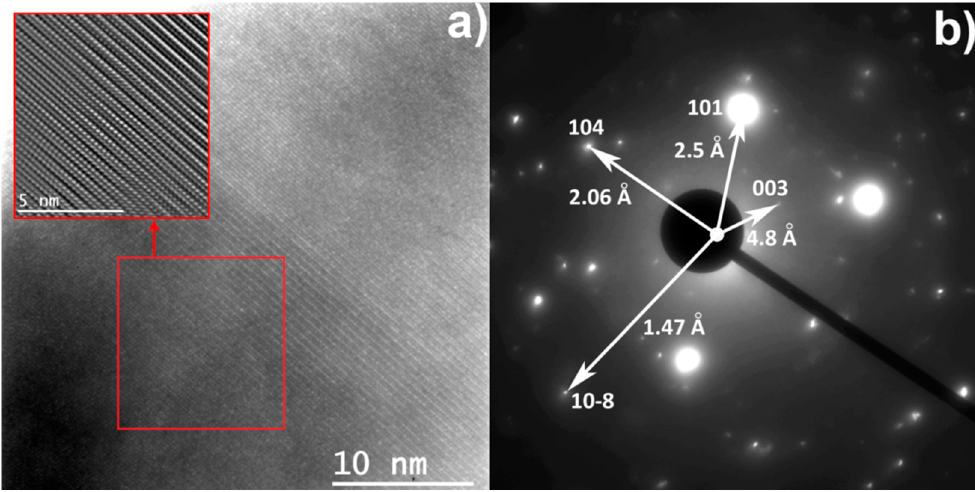
Figure 12. ( a ) High-resolution TEM image of LNO-M-800 sample; inset: results of Fourier filtration of the marked area. ( b ) selected-area electron diffraction (SAED) patterns of the LNO-M-800 sample.